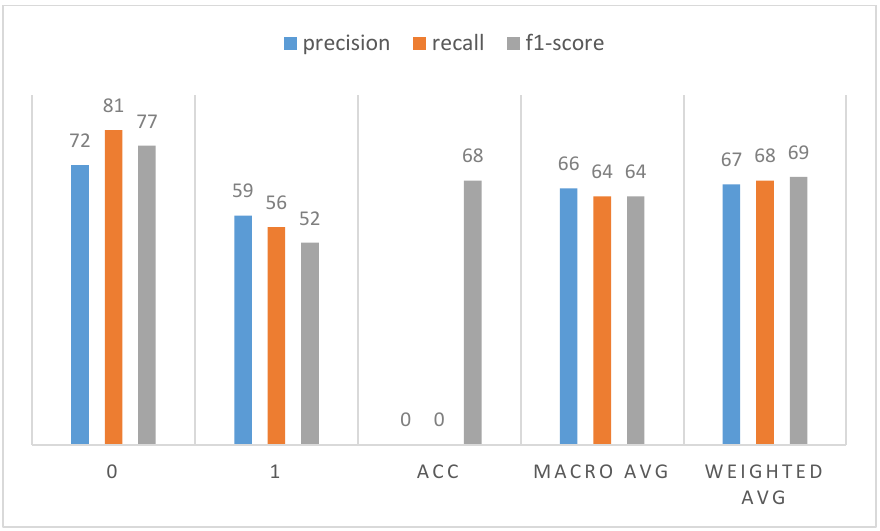
Figure 19. Summary of results for a testing dataset equal to 99% and training dataset of 1%.